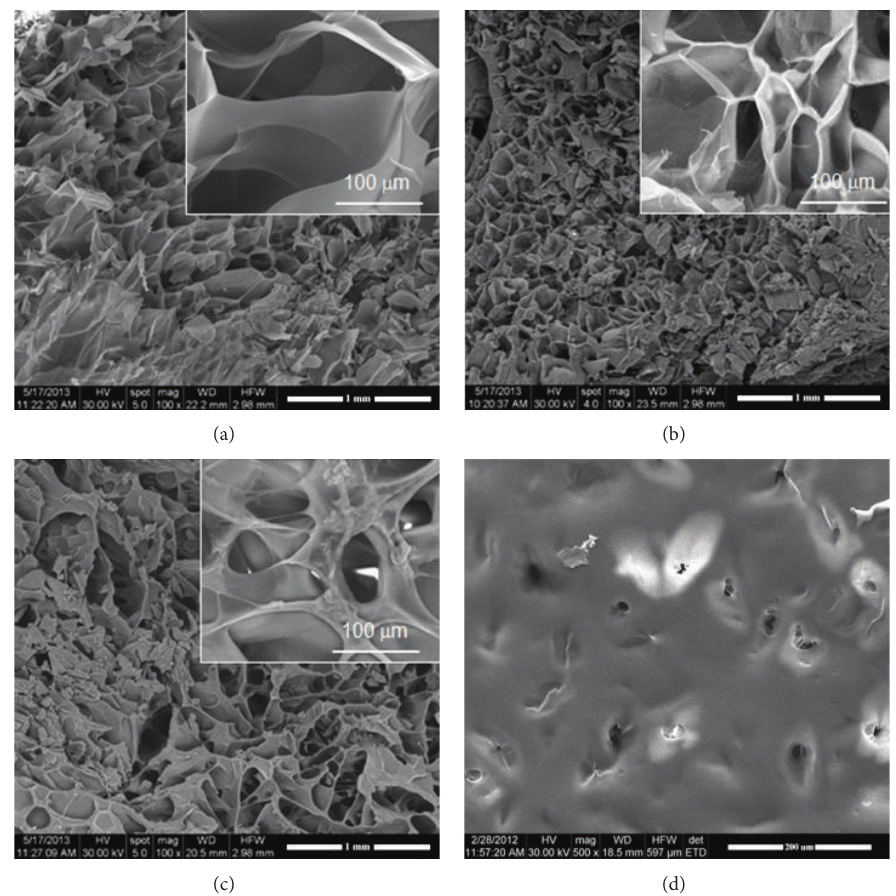
Figure 1: SEM micrographs showing the porosity of the unseeded scaffolds as visible through cross sections: (a) G-A-PAA, (b) G-A, (c) PAA, and (d) surface of PAA negative